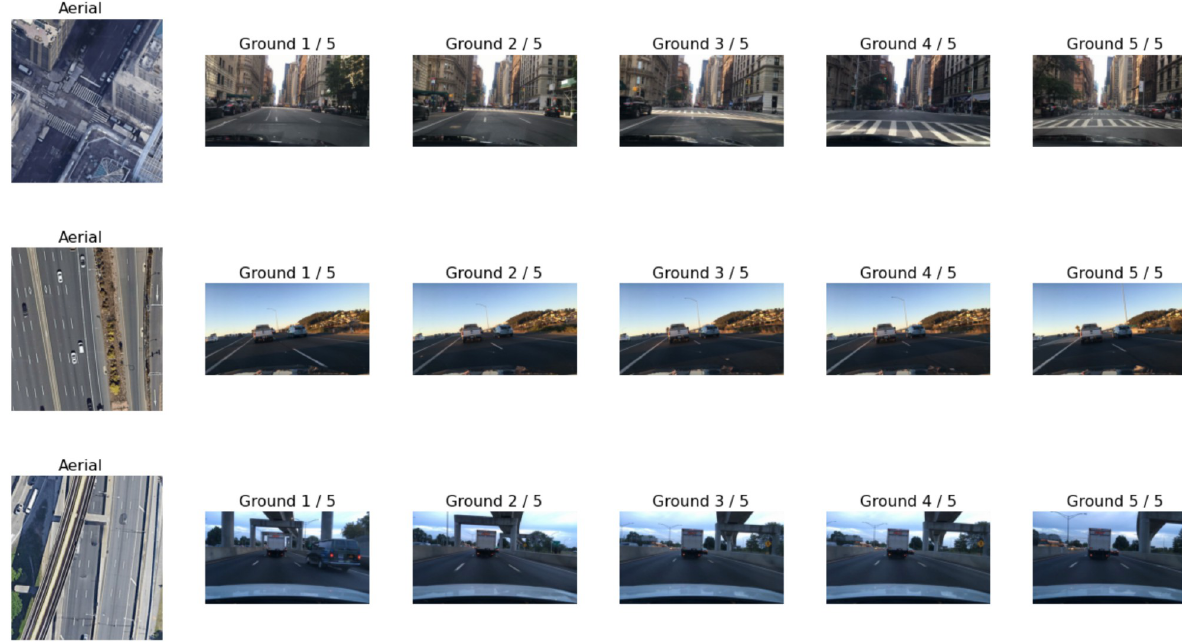
Fig 2. Three examples from our dataset for ground